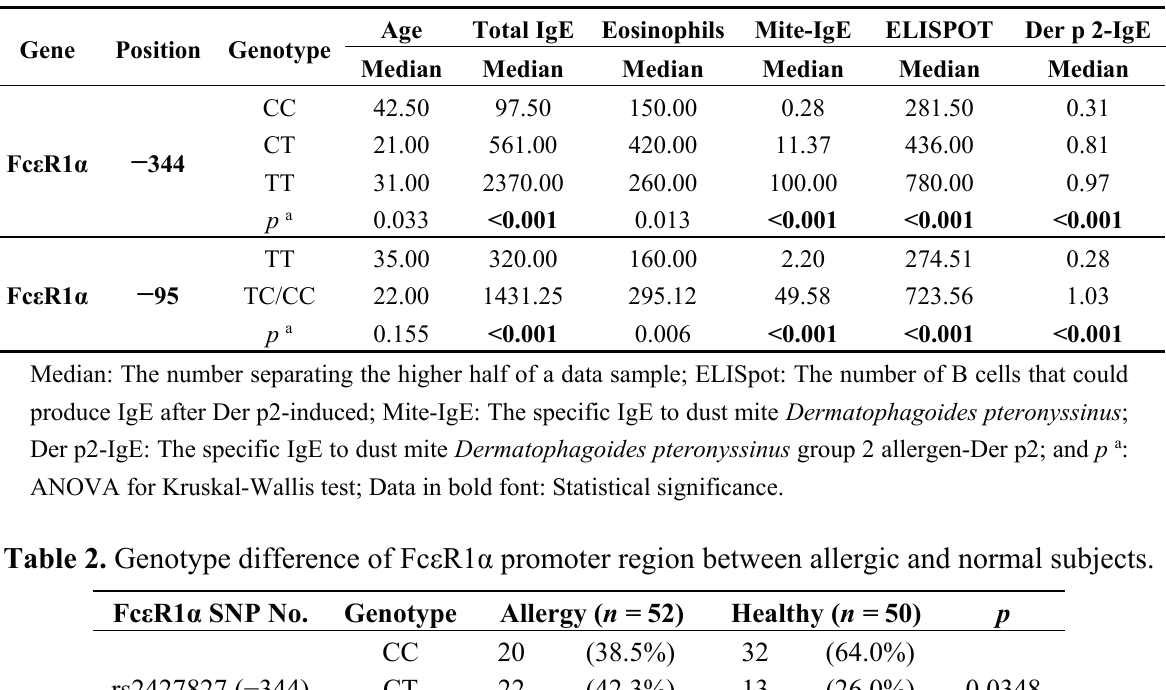
Table 1. Clinical characteristics of different genotypes of the Fc ε R1 α promoter region in allergic patients ( n = 52).